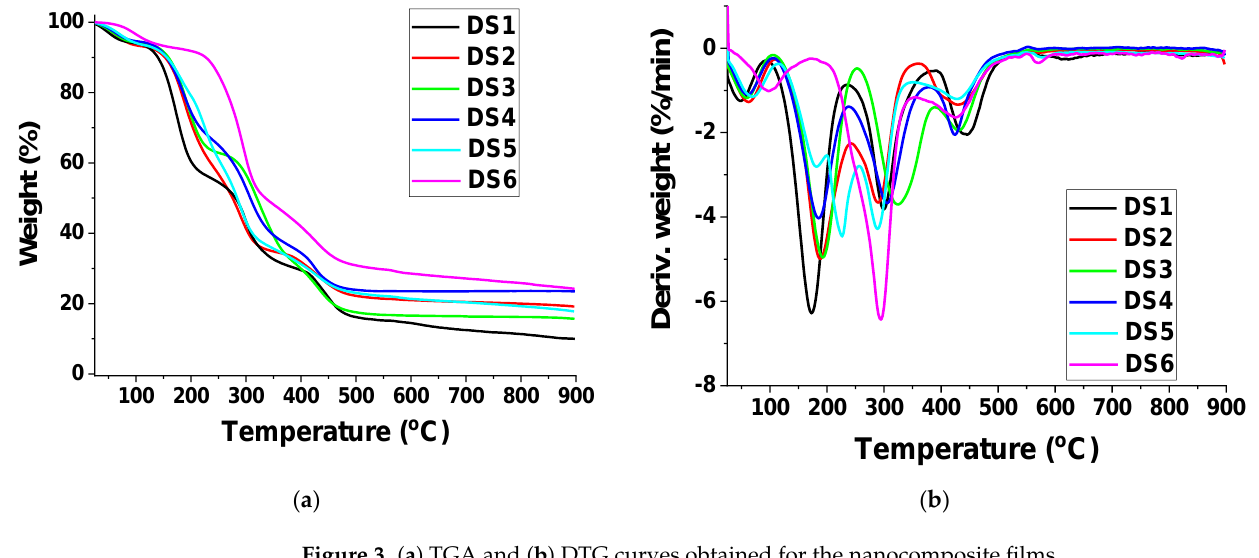
Figure 3. ( a ) TGA and ( b ) DTG curves obtained for the nanocomposite films. Table 3. Thermal properties of the obtained nanocomposites DS1, DS2, DS3, DS4, DS5, and DS6. Sample T 10% , [ ◦